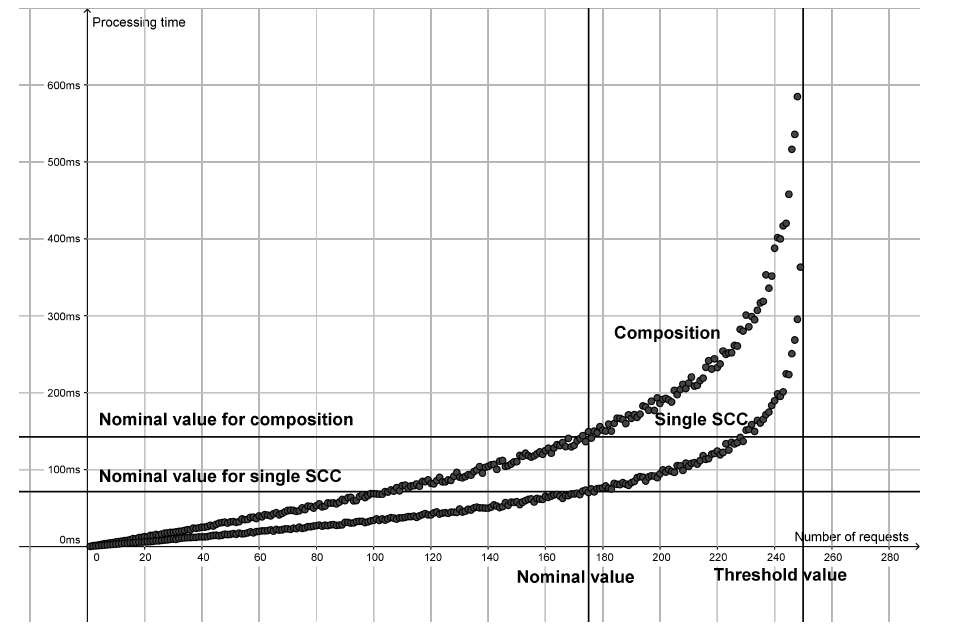
Figure 4. Number of requests and processing time for the composition.